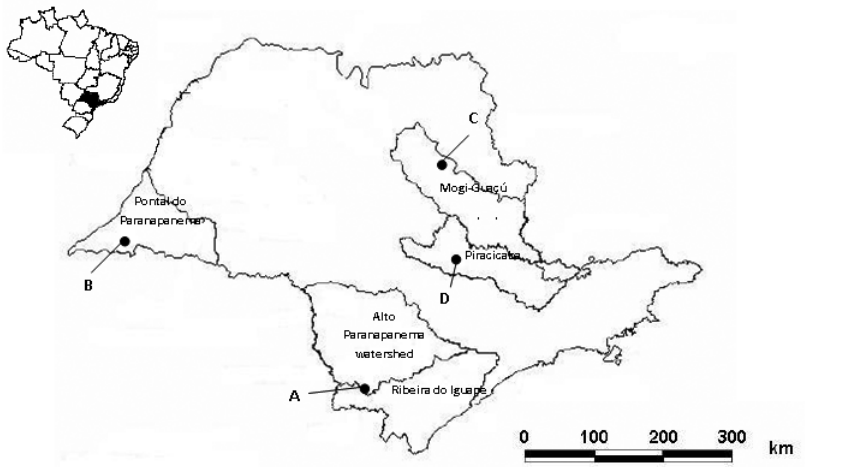
Figure 1 - Map of the state of São Paulo showing the sampling sites located at four watersheds. A : sites 1, 2, 3 and 7; B : sites 4, 5 and 8; C : site 6; D : site 8 and